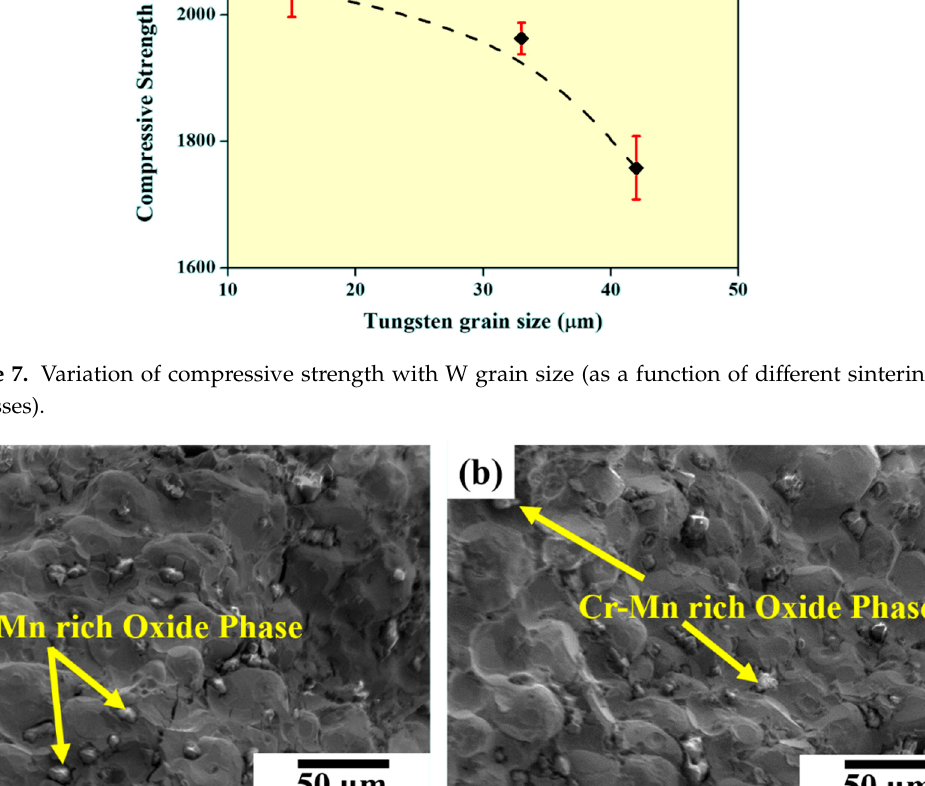
Figure 8. Fractography of bend tested WHHEA specimen consolidated using ( a ) conventional and ( b )